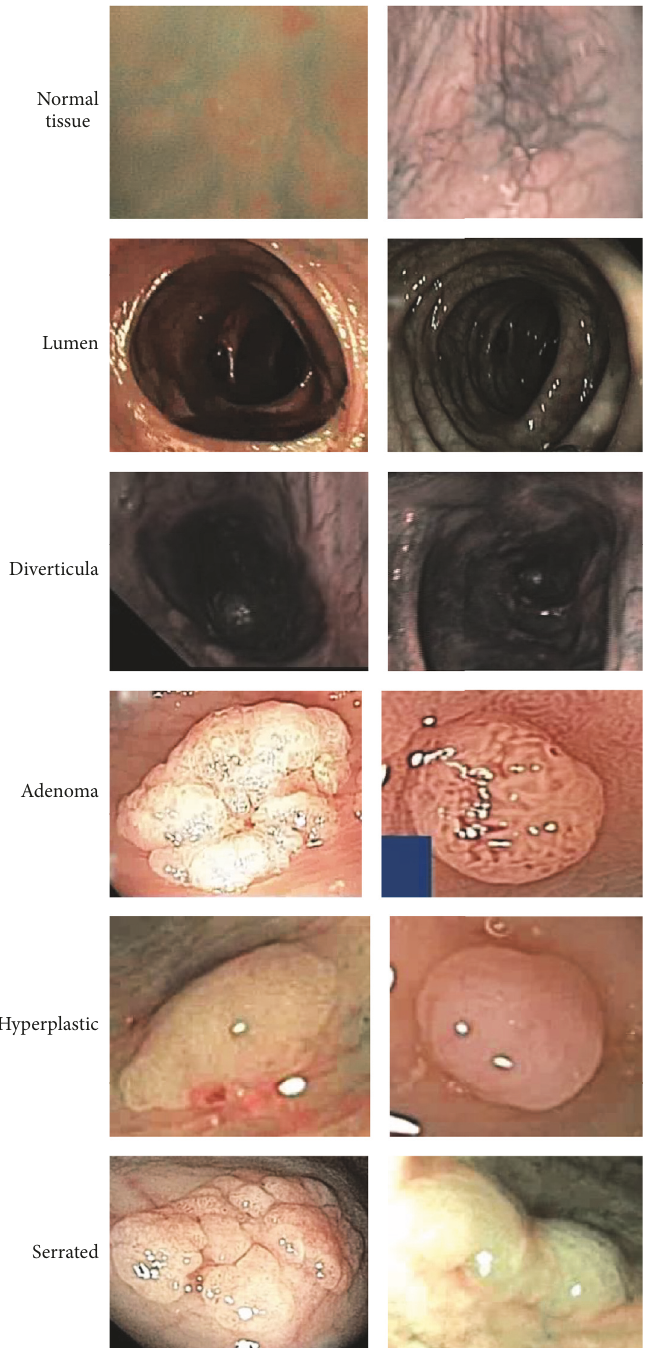
Figure 9: Different categories of video regions and